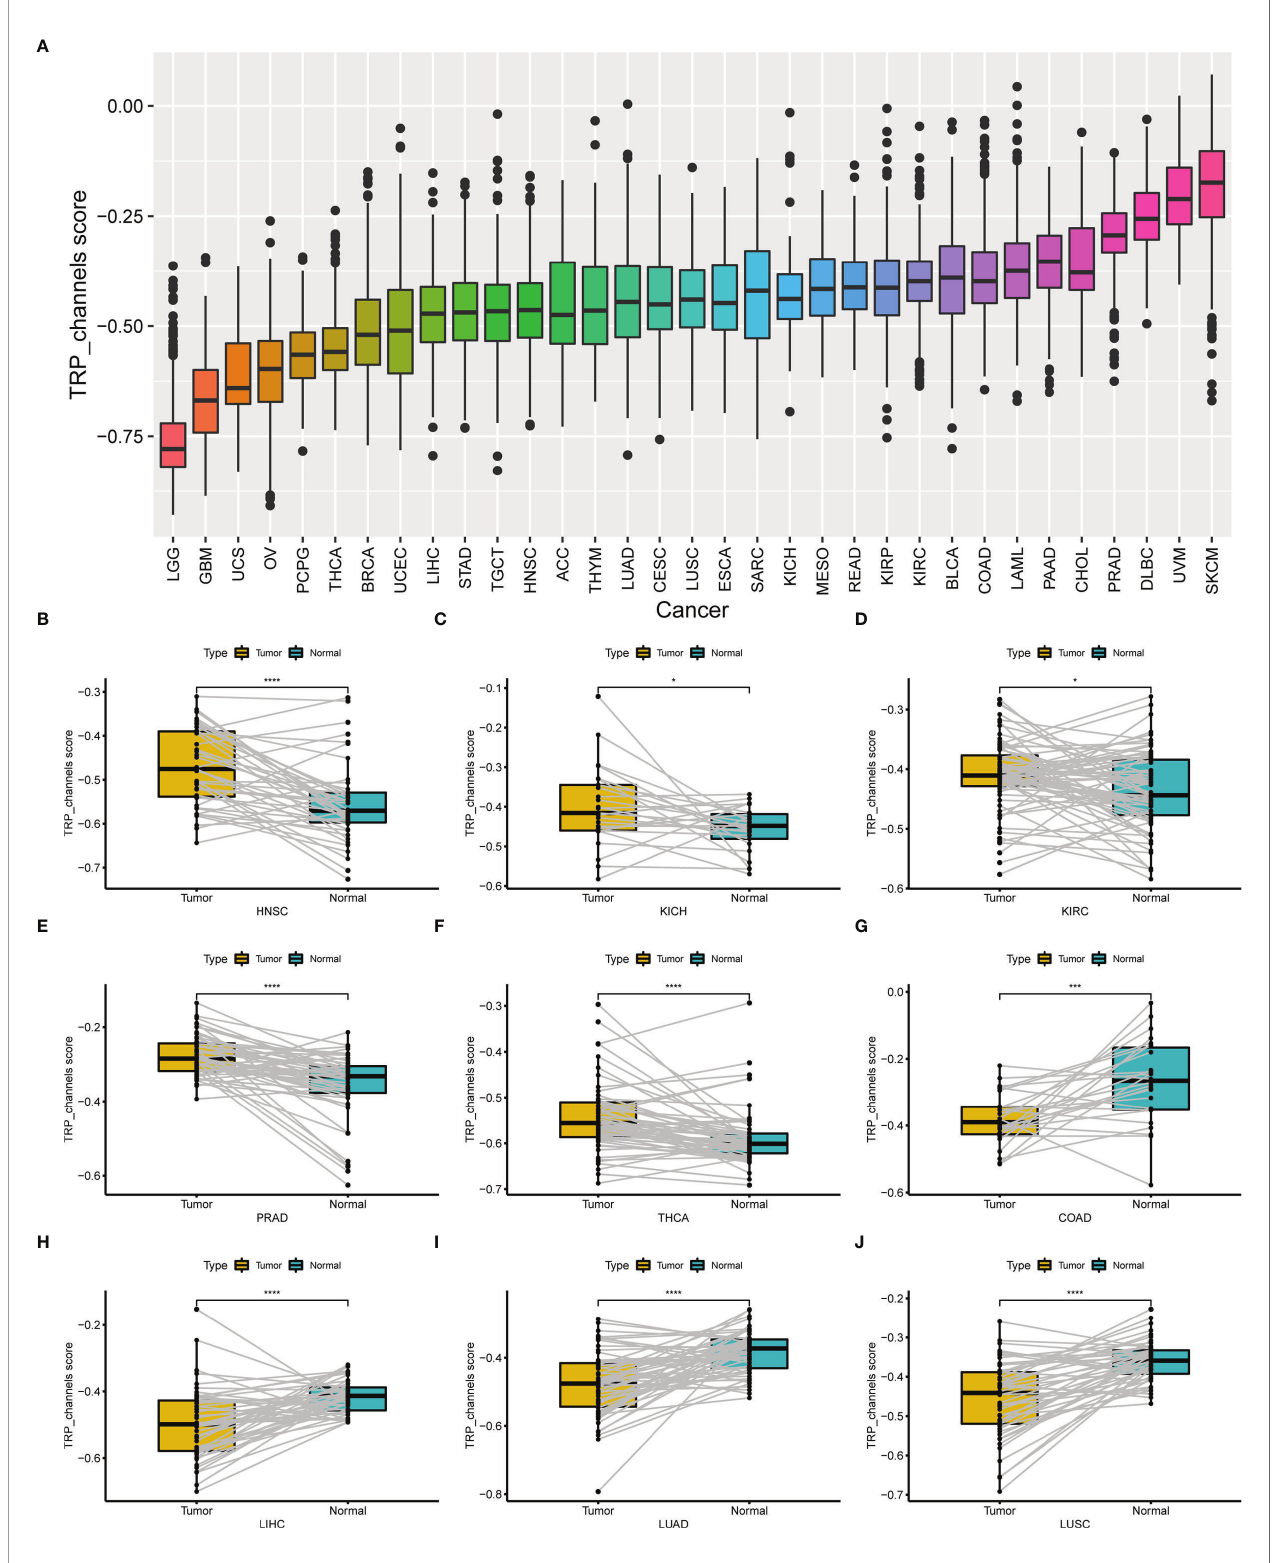
FIGURE 7 | The differential distribution of TRP score. (A) The TRP score distribution in 33 tumour types in TCGA cohort. (B – J) The differential distribution of TRP score in paired tumour and adjacent normal tissues. * P < 0.05, ** P < 0.01, *** P < 0.001, **** P <